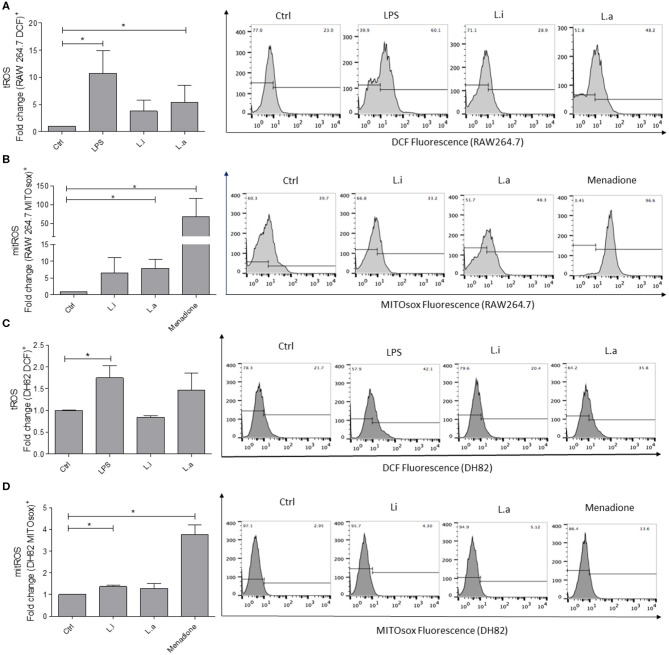
Intracellular ROS production in RAW264.7 murine and DH82 canine macrophages. RAW264.7 (A) or DH82 (C) macrophages were stimulated or not with 1 μg/mL of LPS or infected with L. amazonensis (L.a) or L. infantum (L.i) in a ratio of 5p:1m, and total ROS (tROS) production was detected after 24 h with 0.5 mM DCFH-DA. RAW264.7 (B) or DH82 (D) macrophages stimulated or not with 0.05 mM menadione or infected with L. amazonensis (L.a) or L. infantum (L.i) as above and mitROS production detected after 24 h with 1 mM MITOsox. Data were normalized as fold change in comparison to control cells (unstimulated cells incubated with DCF or MITOsox) and are presented as mean ± SEM of three independent experiments. *p < 0.05. Representative histograms of %DCF-FM+ and MITOSox+ cells of unstimulated (Ctrl), stimulated with LPS, or infected with L. infantum or L. amazonensis are shown. Representative histograms of % of fluorescent cells in unstimulated cells (Ctrl) or LPS- or menadione-stimulated; infected with L. infantum or L. amazonensis are shown.